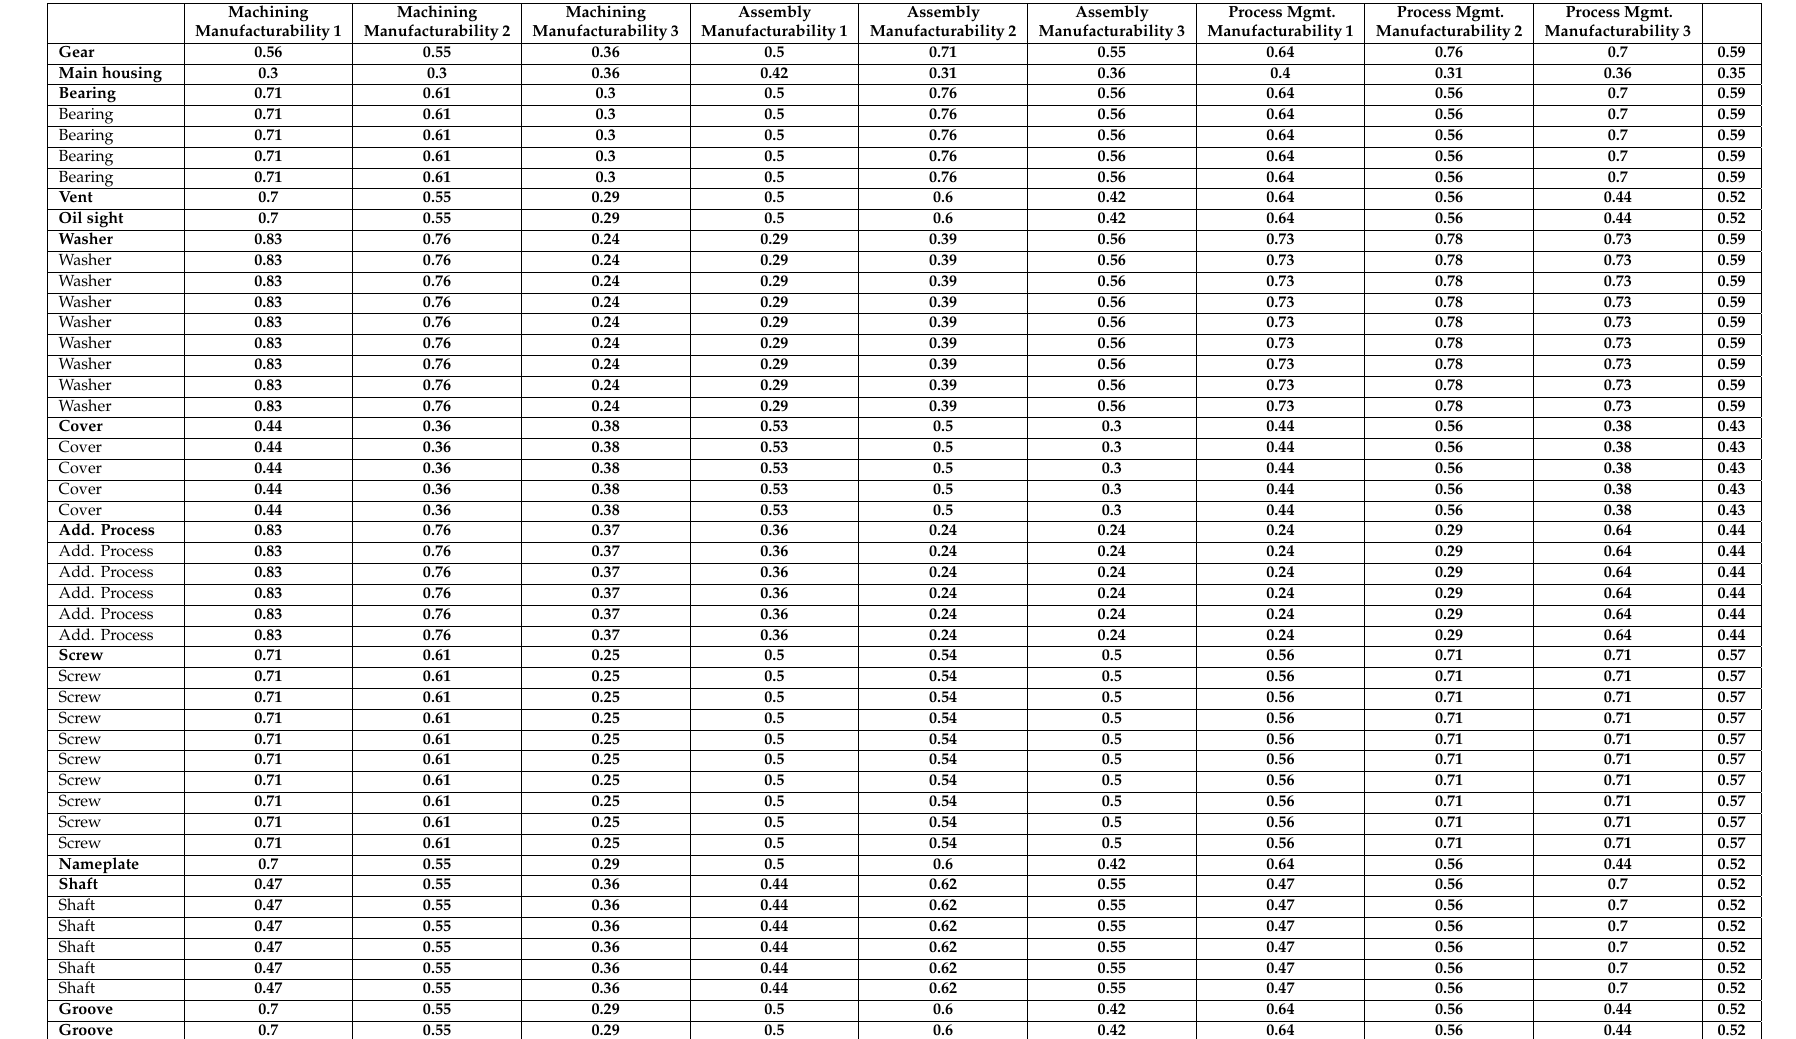
Table 14. A set of fuzzy method results for individual components for specified